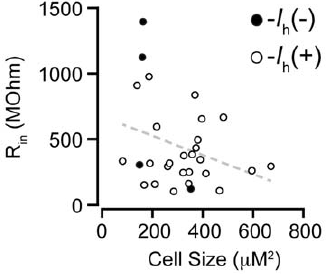
Figure 4. Plot of soma crossectional areas and input resistanc- es for all confirmed GABAergic neurons. There was a trend towards an inverse relationship between these two measures. P =0.09.